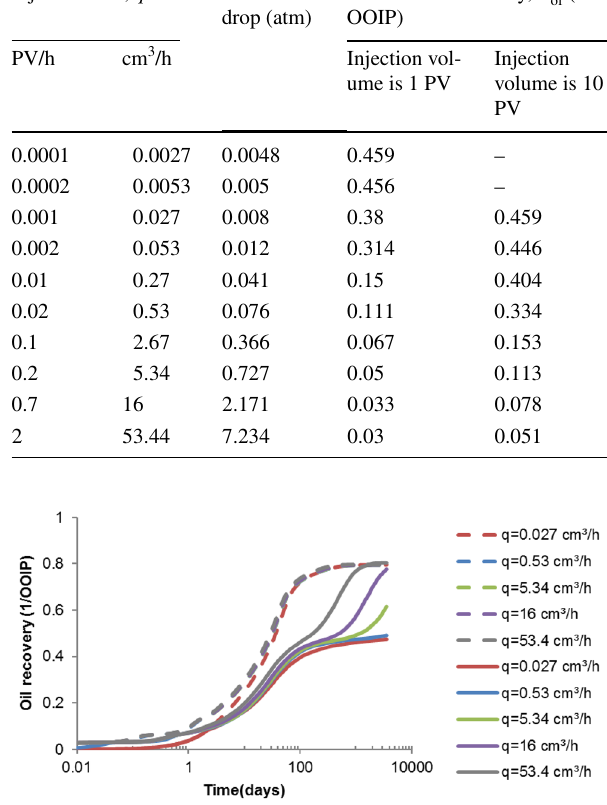
Table 8 Summary of the surfactant flooding with different injection rate when the surfactant diffusion is zero Injection rate, q